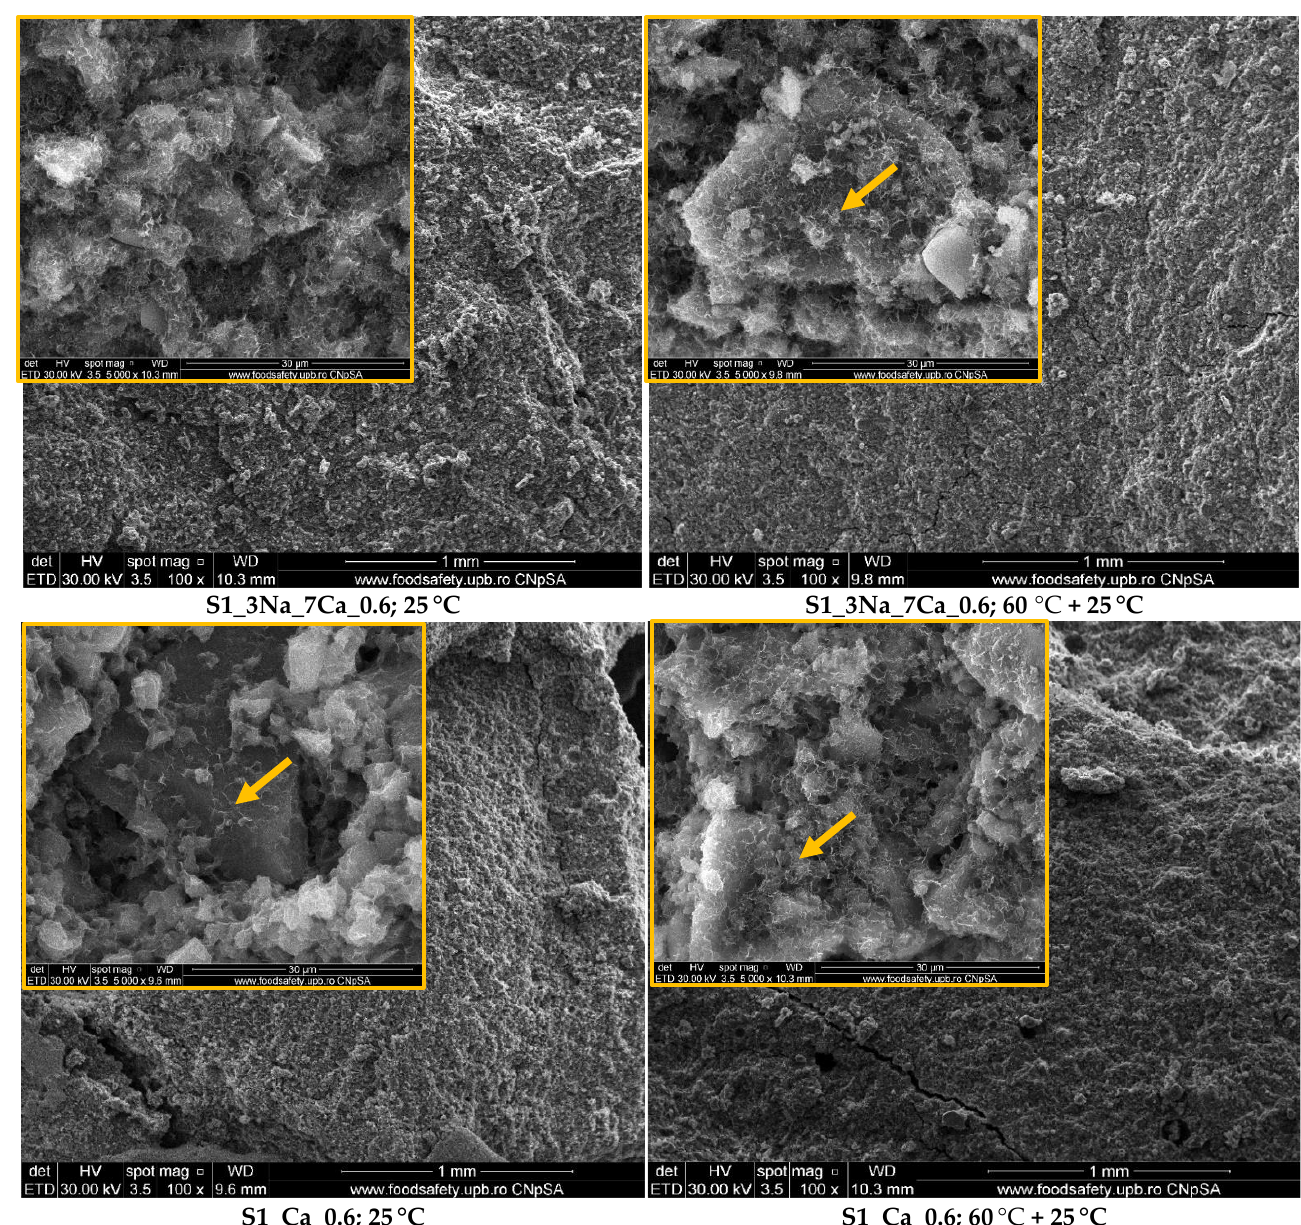
Figure 4. Electronic microscopy analyses (SEM) of samples based on S1 glass powder stored at 25 °C or at 60 °C for the first 24 h and then at 25 °C.